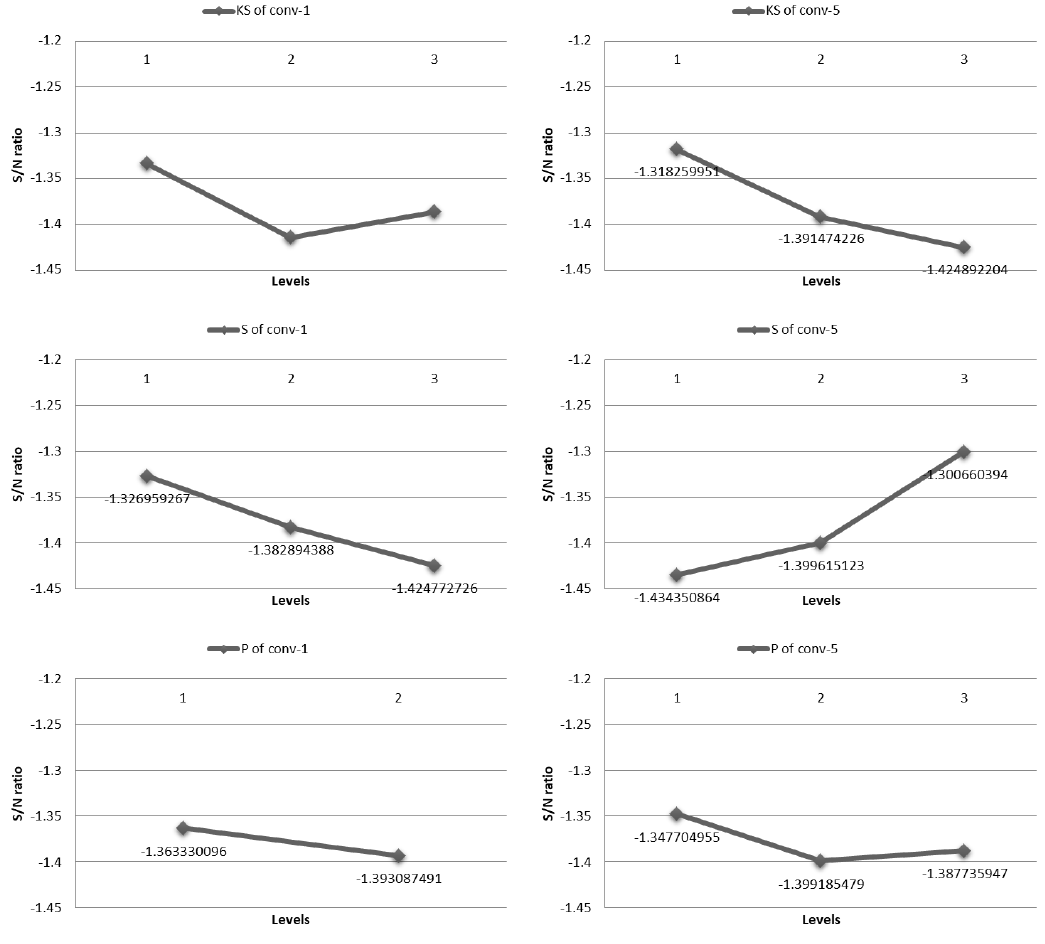
Figure 6. E ff ects of all factors in the CIA data set. Figure 6. Effects of all factors in the CIA data set. Table 6. Average S/N ratio of each factor and level in CIA data set.